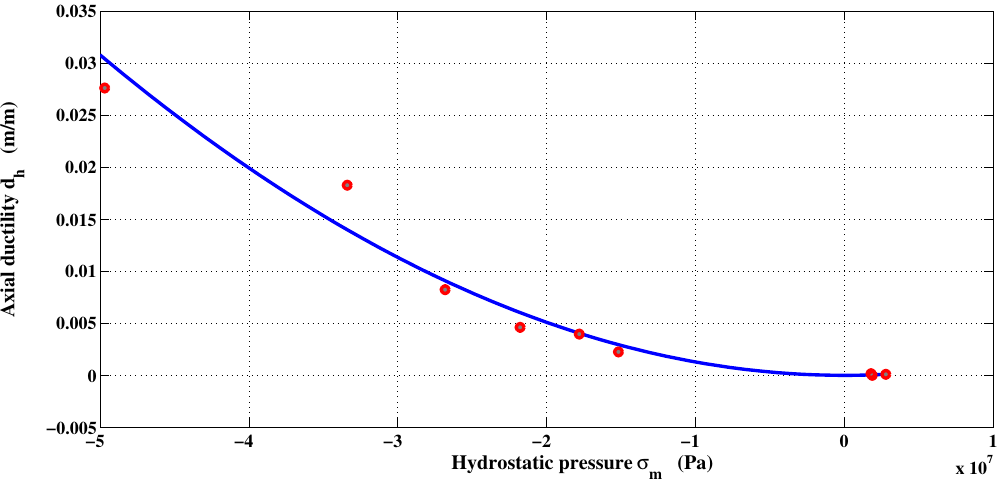
Figure 6. Ductility curve versus mean